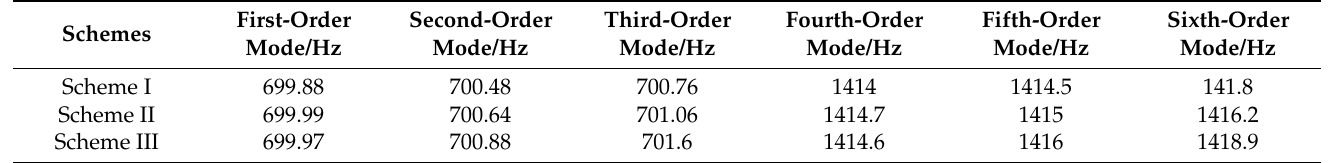
Table 5. Modal natural